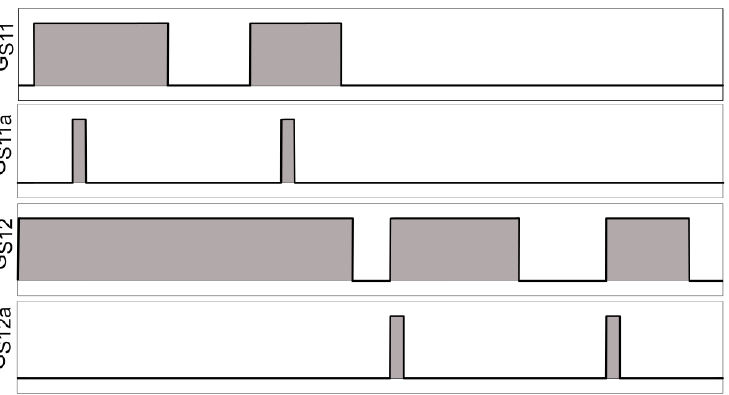
Figure 7. Control signals of switches S11 and S12, and their auxiliary switches S11a and S12a.